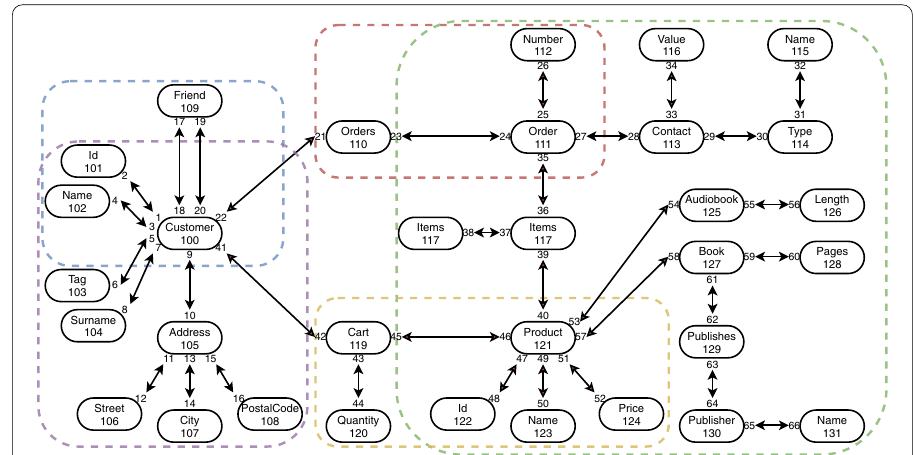
Fig. 3 Schema category extracted from the sample ER schema in Fig.